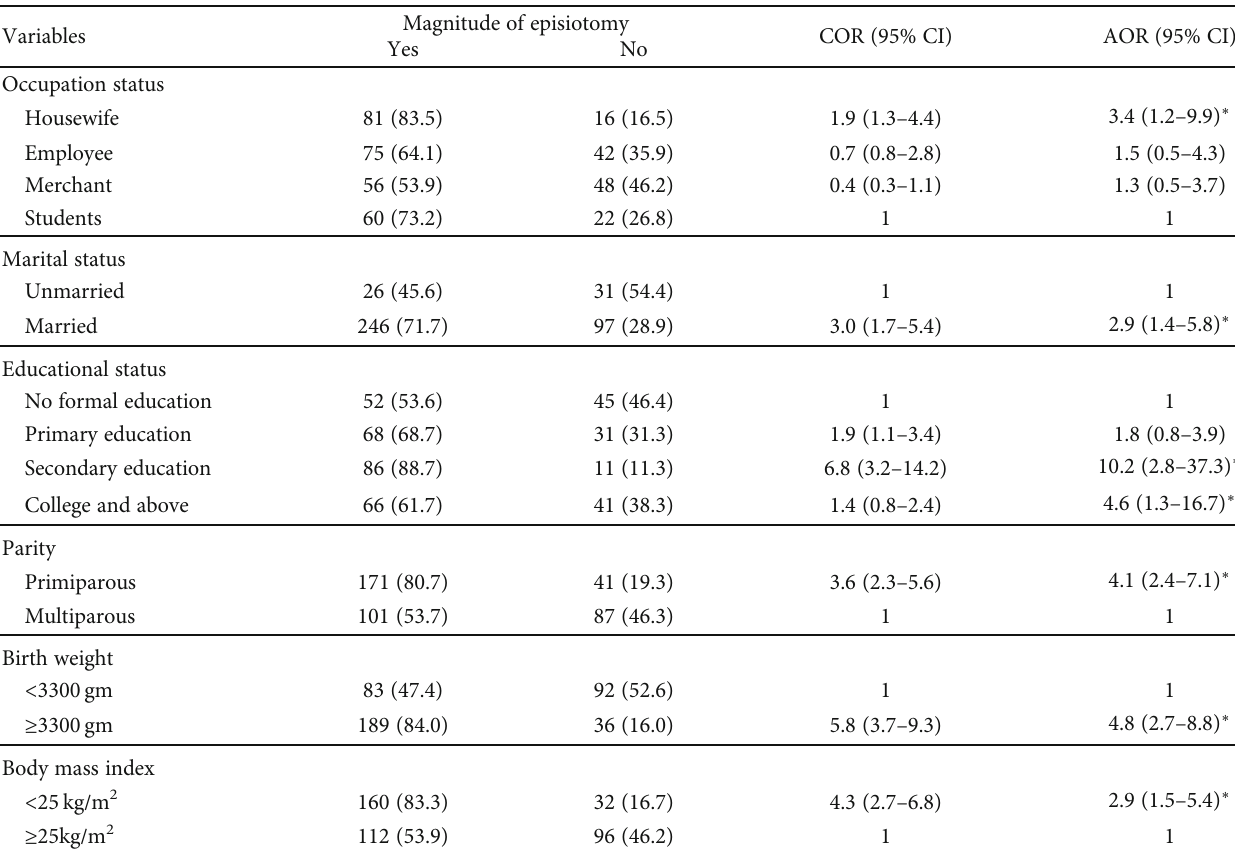
Figure 1: Indication of episiotomy among mothers who gave birth in Arba Minch General Hospital, 2019. Table 5: Bivariable and multivariable logistic regression analysis outputs of the factors associated with the magnitude of episiotomy for mothers who gave birth vaginally in Arba Minch General Hospital, 2019 ( N = 400